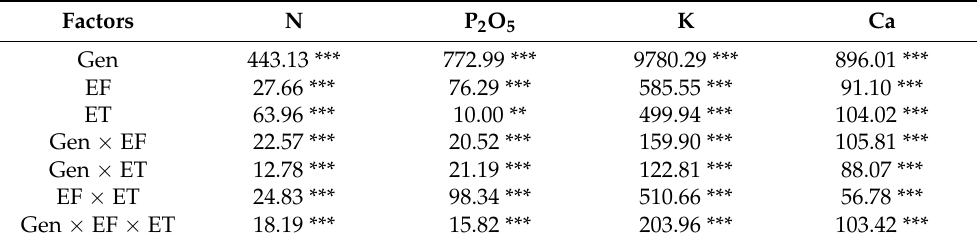
Table 4. Analysis of variance (mean squares) for different parameters of 5 soybean genotypes after applied DC voltage (electrostatic field).